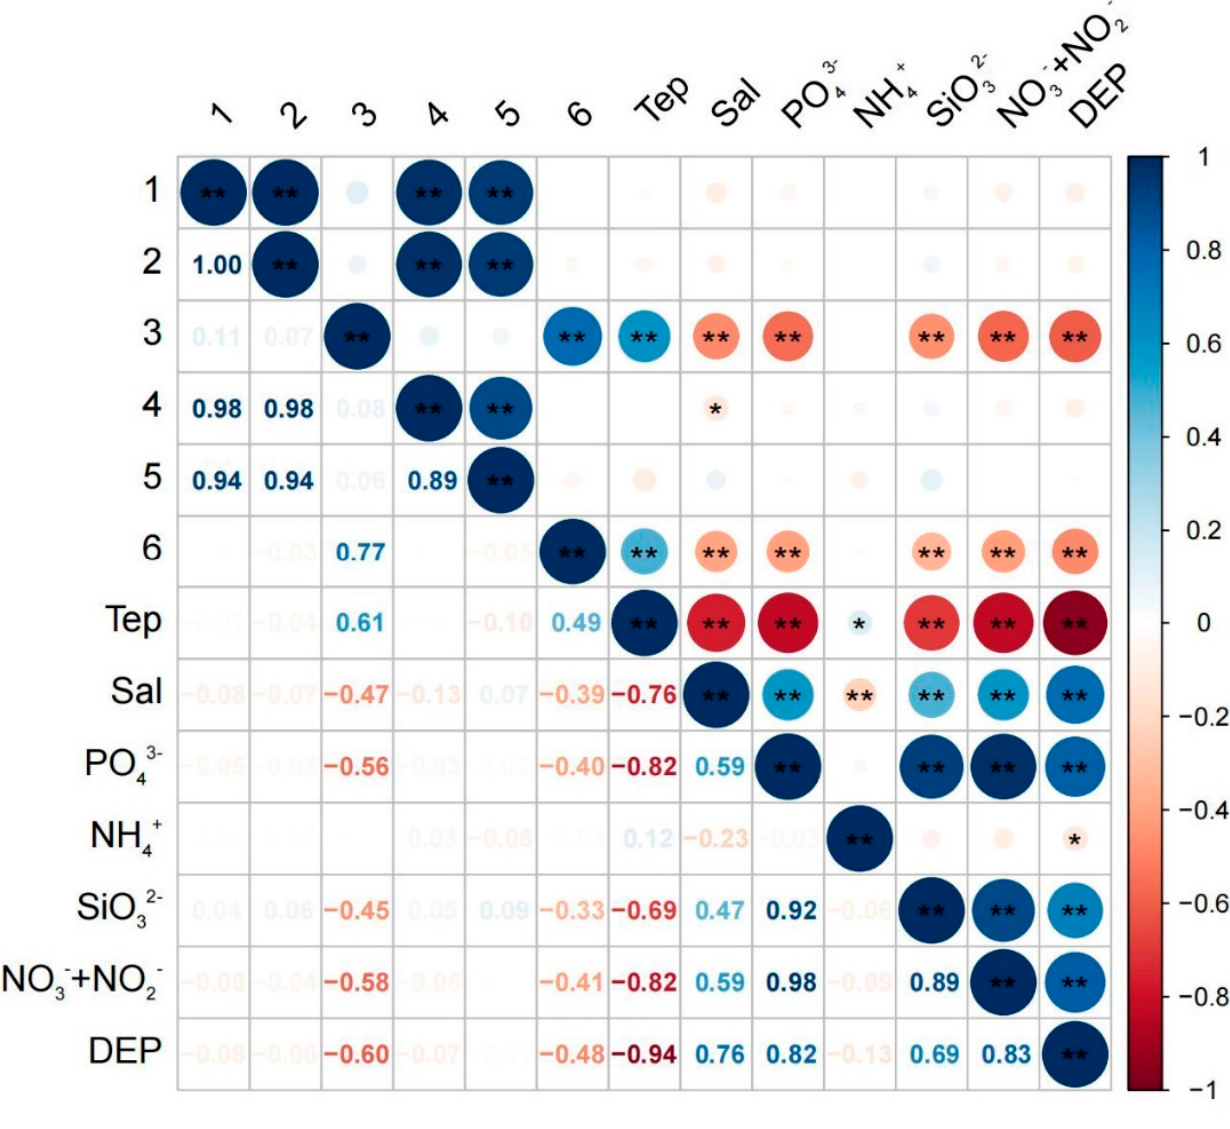
Figure 7. Pearson analysis between phytoplankton and environmental factors. 1, phytoplankton; 2, diatom; 3, dinoflagellate; 4, Nitzschia sp.; 5, Thalassionema nitzschioides; 6, Scrippsiella trochoidea; DEP, depth; Tep, temperature; Sal, salinity; PO 4 3 − , phosphate; SiO 3 2 − , silicate; NH 4 + , ammonium salt; NO 2 − , nitrite; NO 3 − , nitrate.